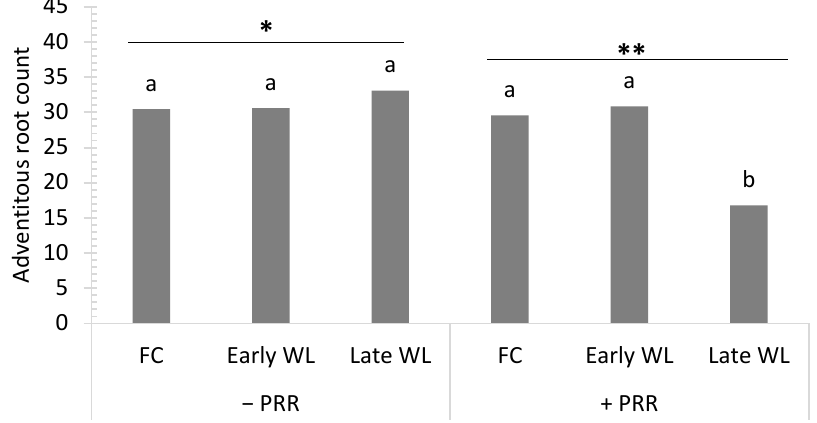
Figure 6. Main Phytophthora medicaginis infection (PRR) and two-way PRR by waterlogging (WL) (field capacity (FC), early and late WL) effects on adventitious root counts in three chickpea genotypes. Letters indicate the significant difference in the two-way interaction ( p < 0.05). * and ** indicate significant differences at the main effect level PRR ( p < 0.05).